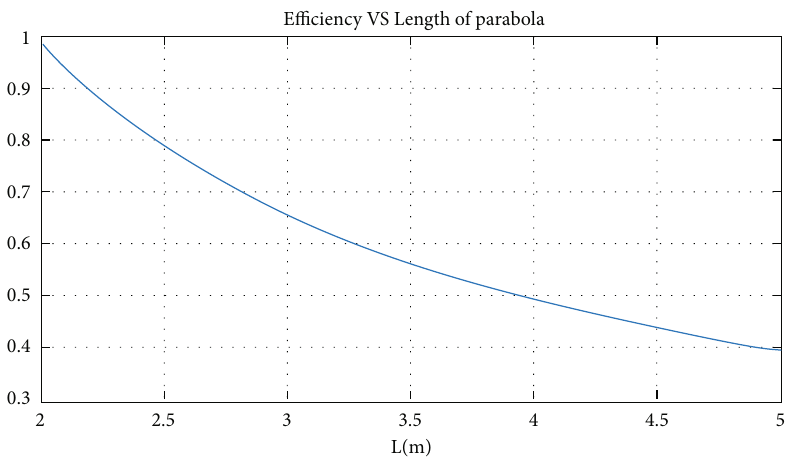
Figure 6: Changes in the e ffi ciency of the absorber pipe by the length of